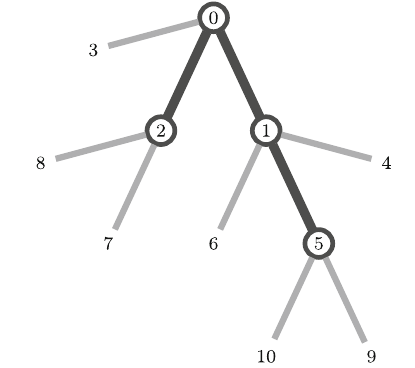
Fig. 5 Schematic architecture of Hammer . The flow of user specified choices or event data is shown by yellow arrows. Blue (green) arrows denote the flow of calculational information, in particular amplitude, weight or rate (form factor) tensors. Red arrows highlight the flow of Hammer output, which may be saved or reloaded. Most internal Hammer classes are not shown in this schematic